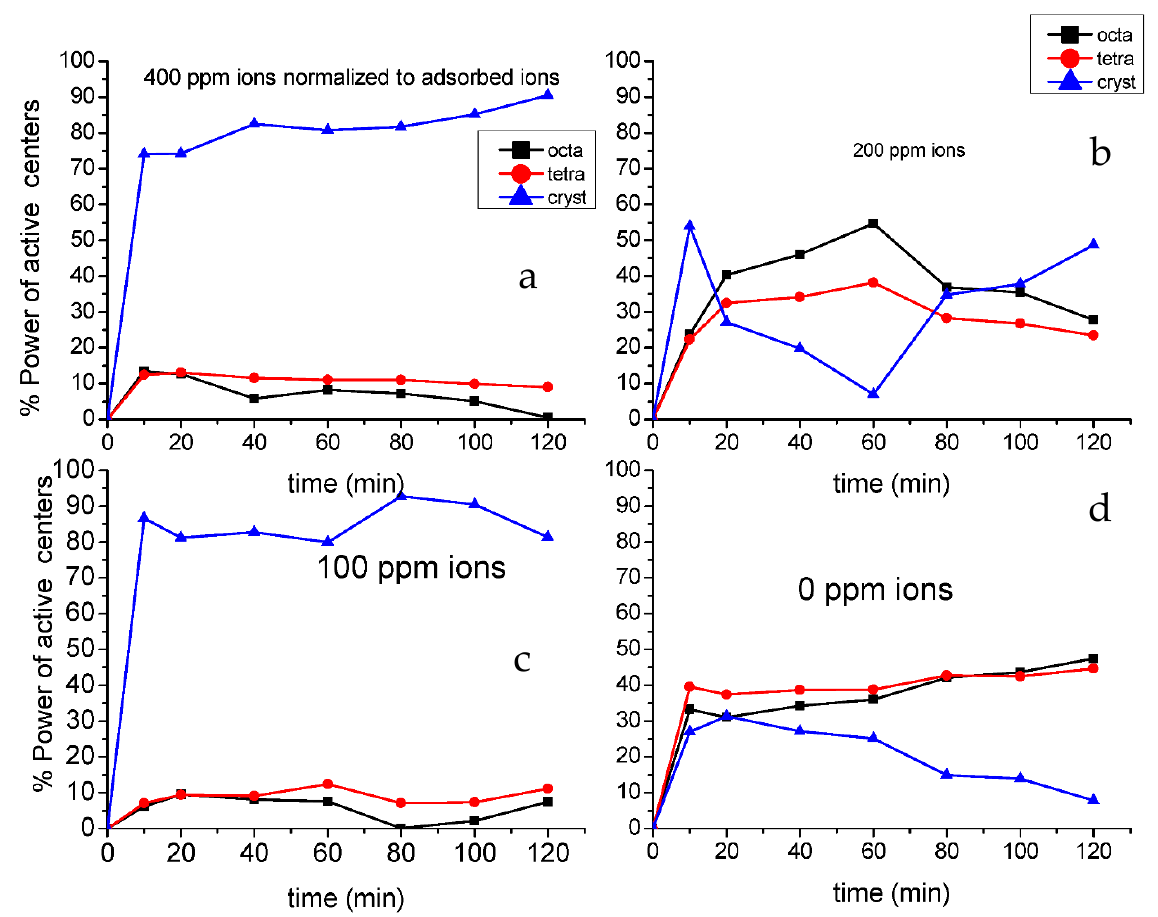
Figure 10. The power of each active site as a function of time with different initial concentrations of ions: ( a ) 400 ppm; ( b ) 200ppm; ( c ) 100 ppm; ( d ) 0 ppm.